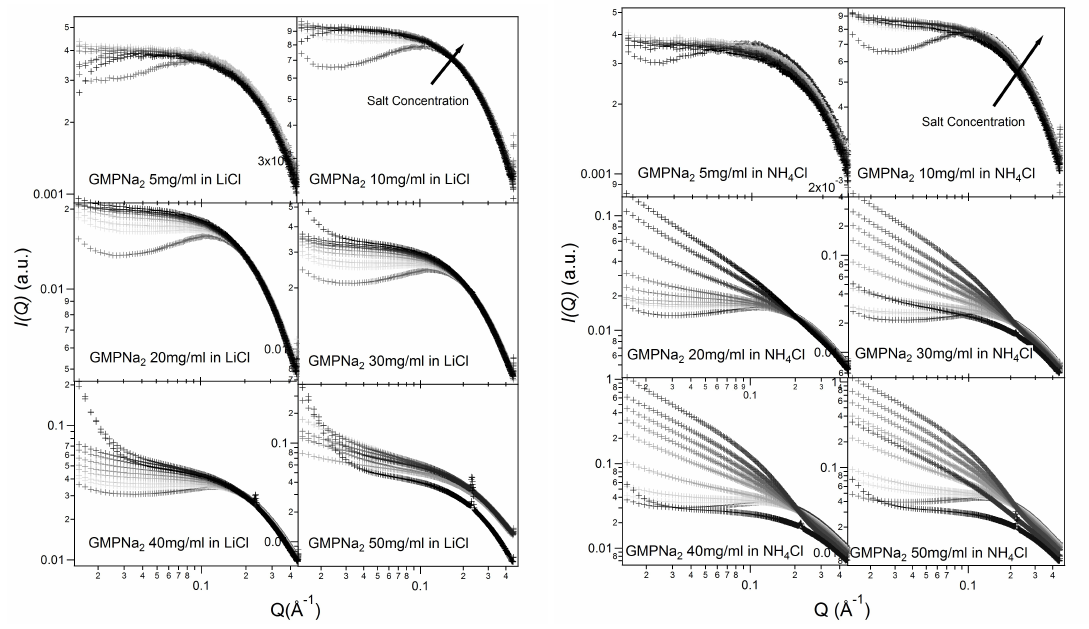
Figure 3. SAXS profiles for GMPNa 2 in LiCl and NH 4 Cl solutions at 24 ◦ C. In each frame, GMP concentration is reported. The grey color of the lines is related to the salt molarity of the solution, that increases, as the arrow indicates, from 0.06 M up to 1.0 M.